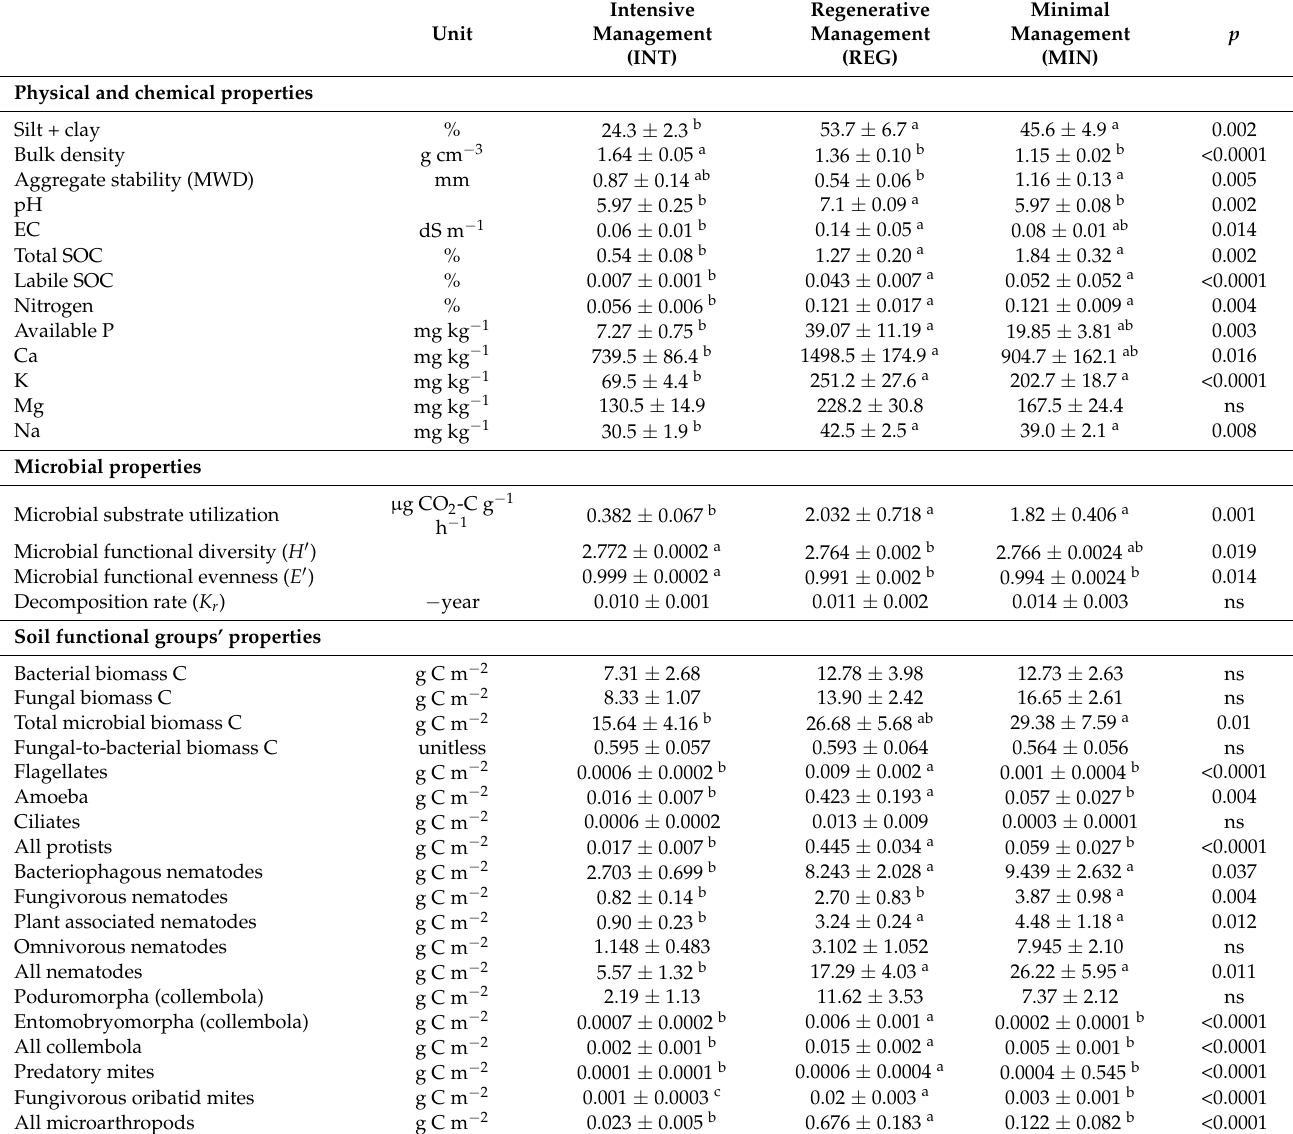
Table 1. Physical, chemical, and biological properties of the soils of the three vineyards studied in this work under contrasting management. Mean ± standard error, with n = 16 samples, except for microbial substrate utilization, microbial functional diversity, and microbial functional evenness, with n = 8. The abundance of the soil functional groups is expressed in g C m − 2 . All data correspond to the upper 15 cm of the soil. MWD: Mean Weight Diameter; For each line, different letters (a, b) indicate significant differences between treatments after ANOVA; ns: non-significant